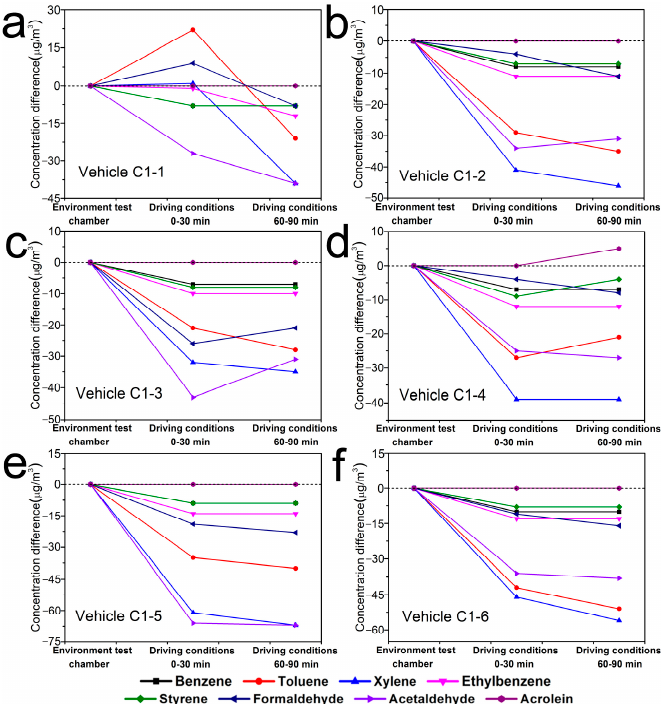
Figure 5. Concentration changes of eight confirmed compounds inside six vehicles of Brand C under different conditions (( a ). Vehicle C1-1; ( b ). Vehicle C1-2; ( c ). Vehicle C1-3; ( d ). Vehicle C1-4; ( e ). Vehicle C1-5; ( f ). Vehicle C1-6)). Y -axis indicates the concentration difference between C D(0–30min) and C E , C D(60–90min) and C E